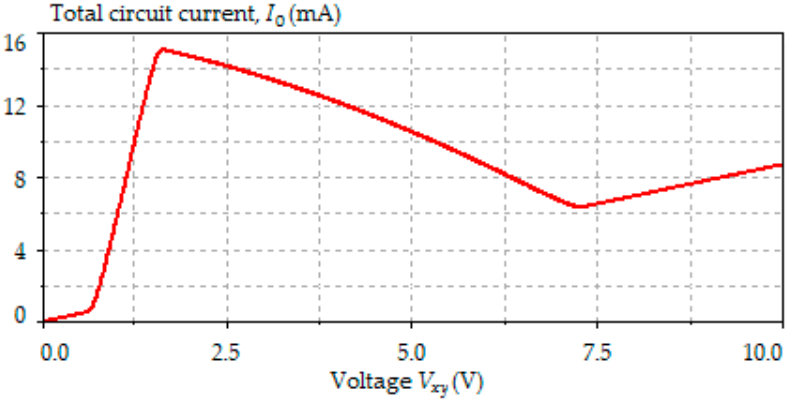
Figure 4. Oscillator current-voltage characteristics.